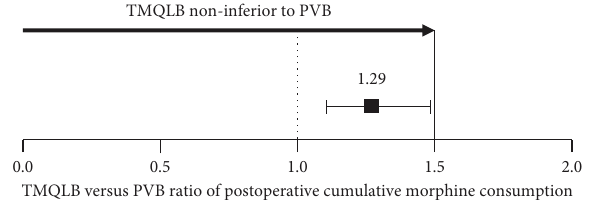
Figure 4: Noninferiority diagram of postoperative 48-hour cu- mulative morphine consumption diferences in TMQLB and TPVB group. Error bar: 95% confdence